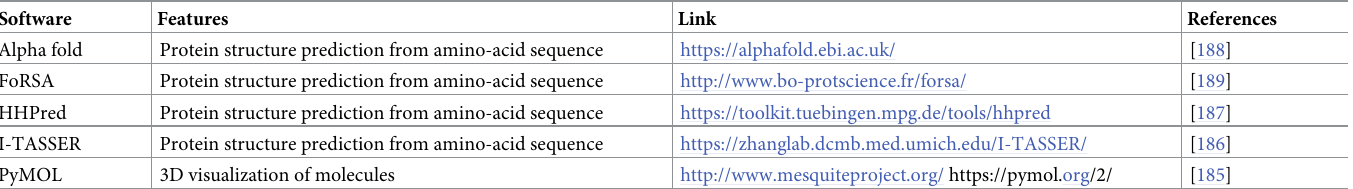
Table 11. List of programs for protein structure